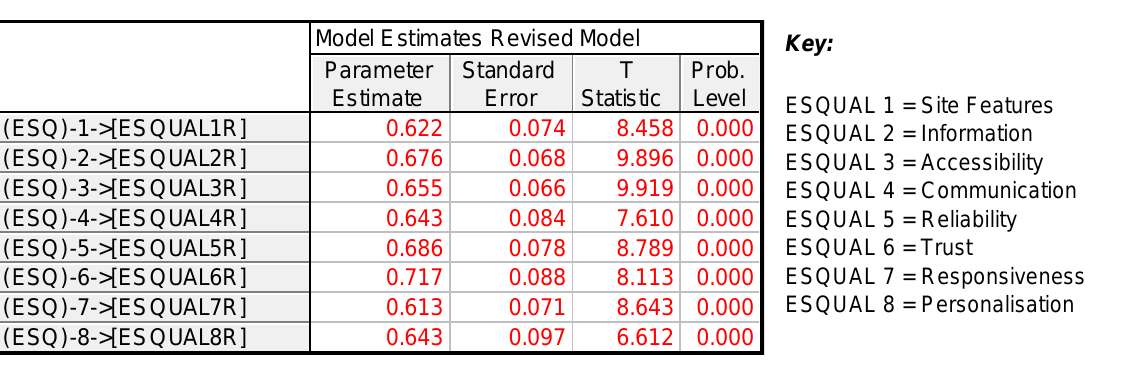
The CFA output shows the predictive capability of the variables on the underlying construct (i.e. e-service quality ). In judging the parameter estimates on their strength of association to the construct, the researchers used a similar